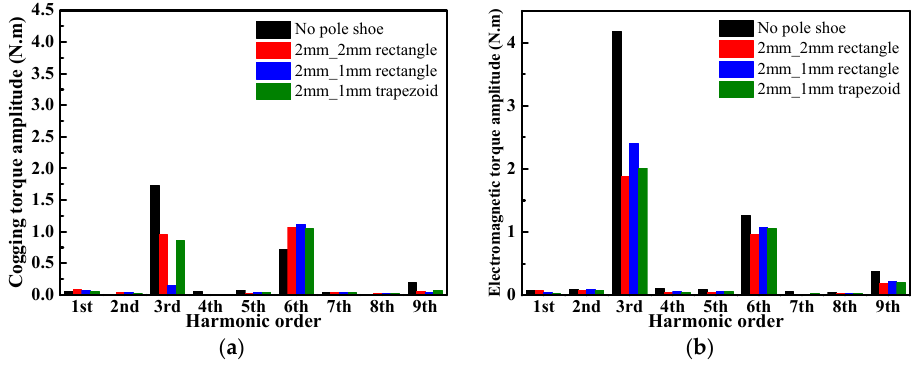
Figure 9. FFT results of cogging torque and electromagnetic torque: ( a ) Amplitude of each harmonic in cogging torque; ( b ) Amplitude of each harmonic in electromagnetic torque.